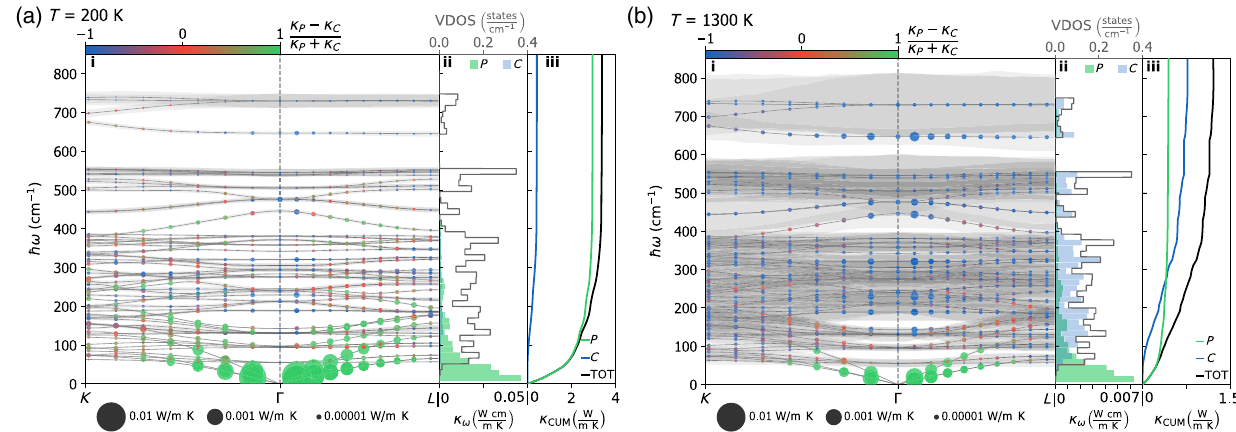
FIG. 4. Vibrational properties and heat conduction mechanisms in La 2 Zr 2 O 7 . Panels (a)(i) and (b)(i) show the phonon spectrum of La 2 Zr 2 O 7 (gray lines) with the phonon linewidths [the full amplitude of the shaded gray areas corresponds to the full phonon linewidth Γ ð q Þ q Þ ffiffiffiffiffiffiffiffiffiffiffiffiffiffiffiffiffiffiffiffiffiffiffiffiffiffiffiffiffiffiffiffi s ] at 200 and 1300 K, respectively. Colored circles represent the phonon eigenstates ð s sampled in the calculation; the area of each p circle is related to its contribution to κ (area ∝ contribution to κ [116]) and the color identifies the origin of the contribution: green for populations ’ propagation and blue for coherences ’ anharmonic couplings [red corresponds to 50% of each; see Eq. (54) and related discussion for details]. In the coherences ’ couplings between two modes ð q Þ s and ð q Þ s 0 the contribution of the single mode s is determined as C ð q Þ s = ½ C ð q Þ s þ C ð q Þ s 0 (cid:2) , where C ð q Þ s is the specific heat of a given phonon (see Appendix E for details). Panels (a)(ii) and (b)(ii) show the thermal conductivity density of states κ ω of populations ( P , green) and coherences ( C , blue) at 200 and 1300 K, respectively. The gray line shows the vibrational density of states (VDOS). Panels (a)(iii) and (b)(iii) show the cumulative total thermal conductivity (in black) as a sum of the populations ’ contribution ( P ) in green and coherences ’ one ( C ) in blue, at 200 and 1300 K, respectively. At 200 K (a) La 2 Zr 2 O 7 is a simple crystal with interband spacings larger than the linewidths and κ P ≫ k C , while at 1300 K it is a complex crystal with interband spacings smaller than the linewidths and κ P ≲ k C .